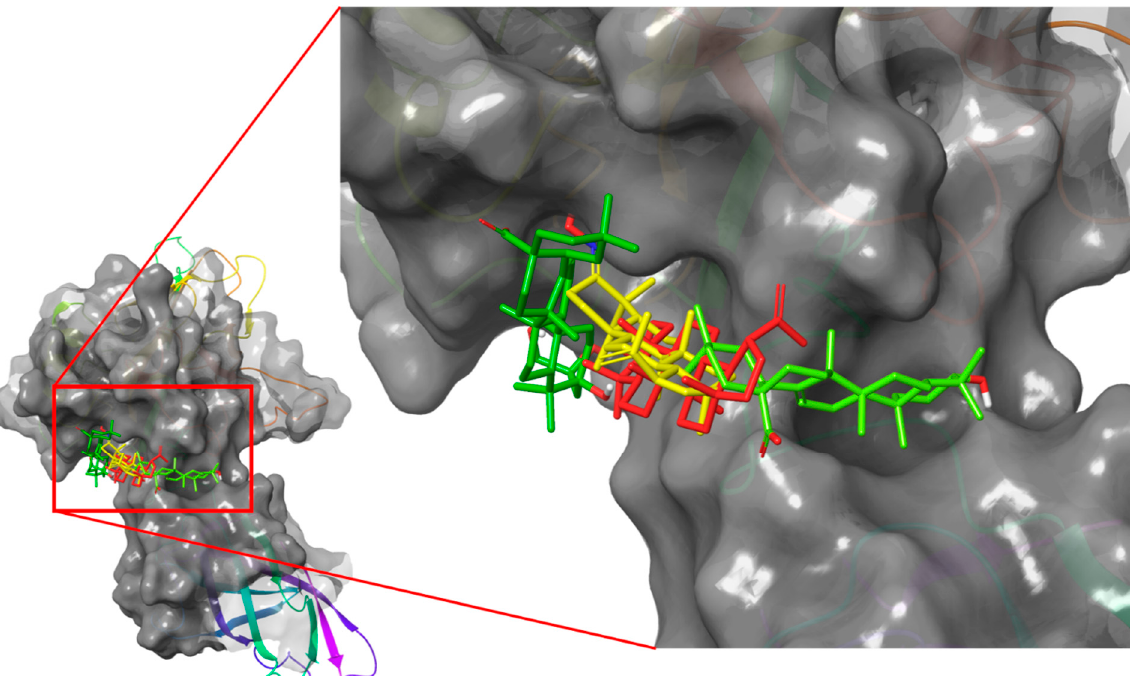
Figure 4. Best docking poses of the compounds 1 (light green), 5 (dark green), 9 (red), and 11 (yellow) in the chain A of the p65 (PDB ID: 2RAM).